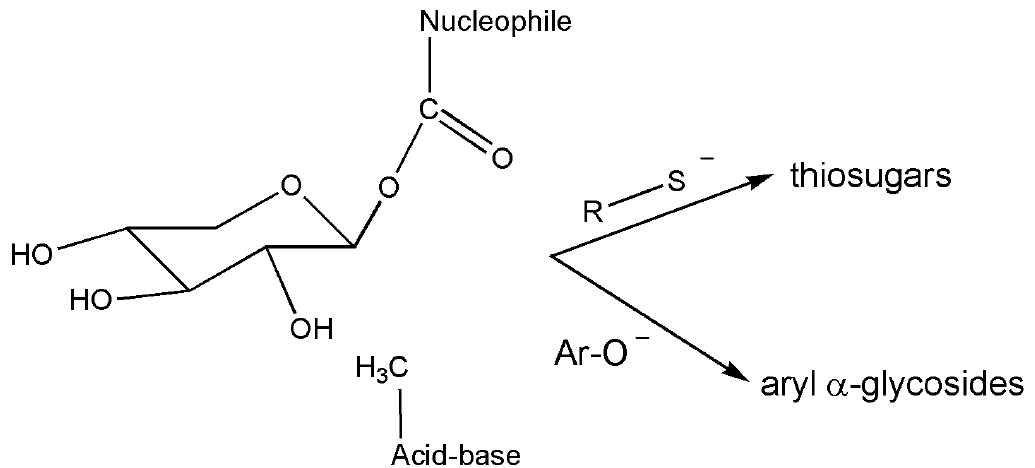
Figure 7. Schematic indication of the thioglycoligase intermediate in the synthesis of thiosugars and aryl